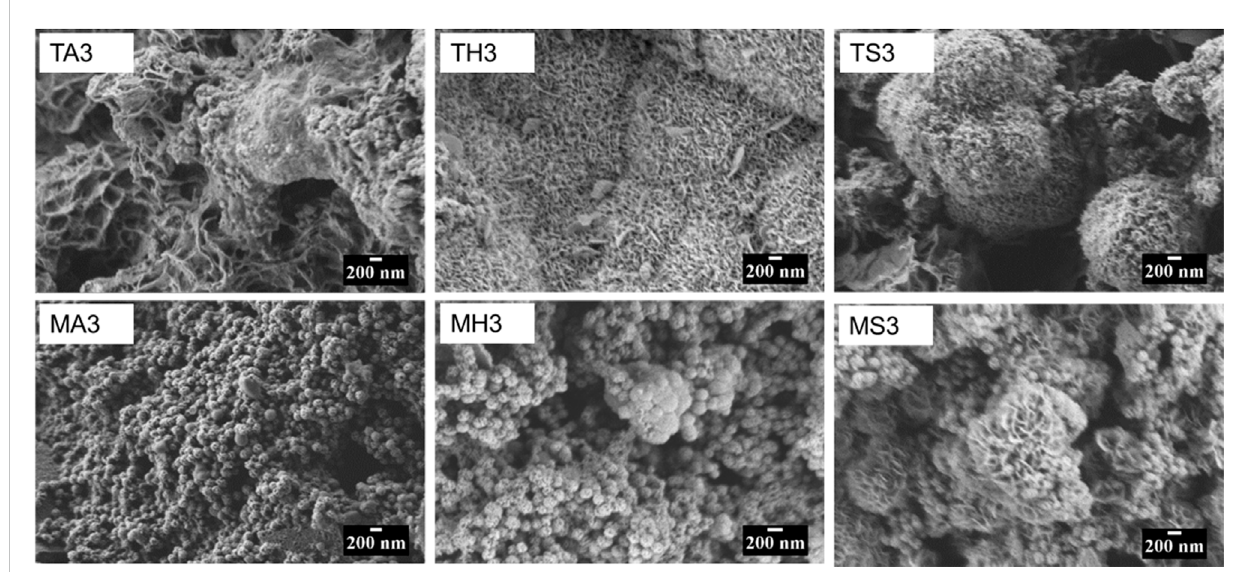
FIGURE 5 Panel comparing the changes in the particle morphology of TCS (top) and MBGNs Bottom) at day 3 of immersion in AS, HBSS and SBF. The micrographs are arranged from right to left in AS (left), HBSS (middle) and SBF (right).